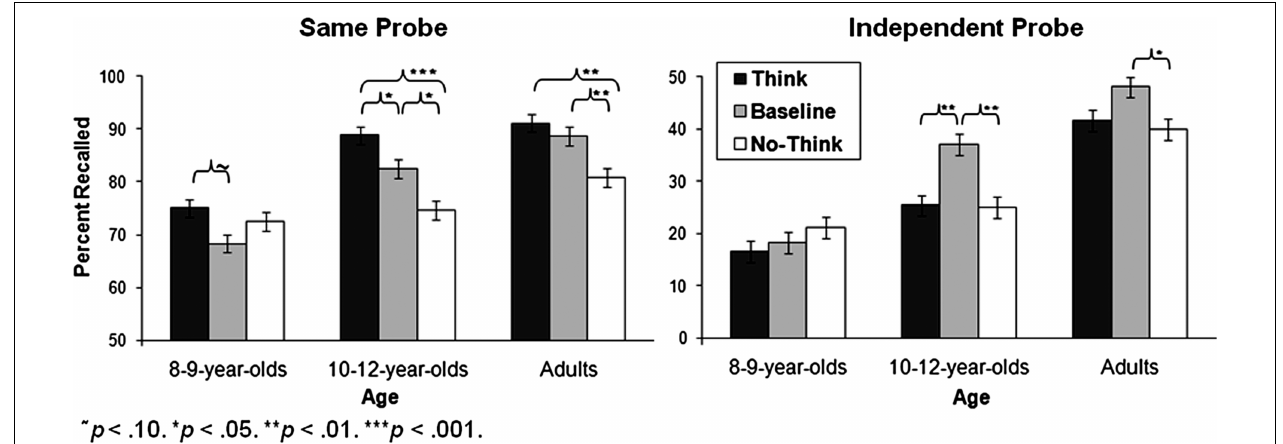
FIGURE 2 | Percent recalled for the SP and IP memory tests as a function of age and